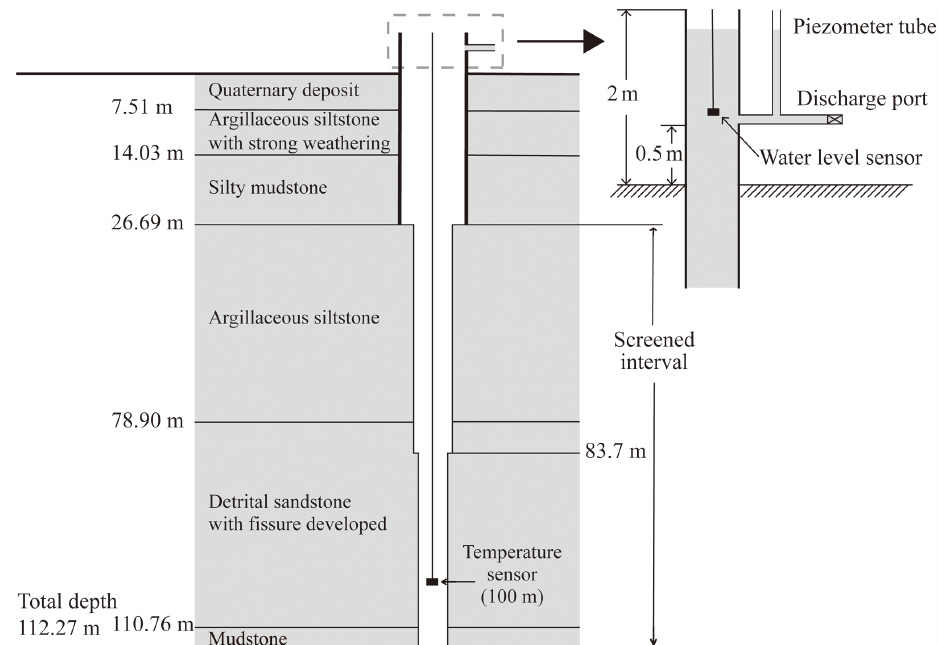
Figure 2. Aquifer lithology and specifications of the DZ well aquifer